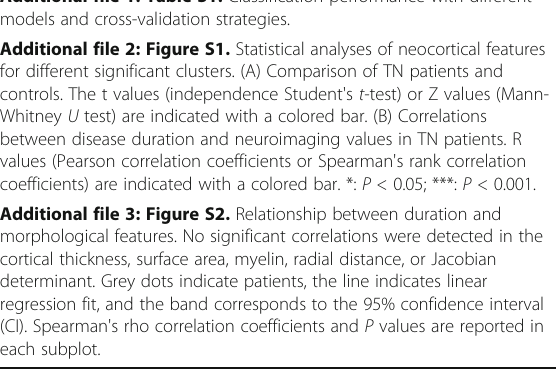
Additional file 1: Table S1. Classification performance with different models and cross-validation strategies. Additional file 2: Figure S1. Statistical analyses of neocortical features for different significant clusters. (A) Comparison of TN patients and controls. The t values (independence Student's t- test) or Z values (Mann- Whitney U test) are indicated with a colored bar. (B) Correlations between disease duration and neuroimaging values in TN patients. R values (Pearson correlation coefficients or Spearman's rank correlation coefficients) are indicated with a colored bar. *: P < 0.05; ***: P < 0.001. Additional file 3: Figure S2. Relationship between duration and morphological features. No significant correlations were detected in the cortical thickness, surface area, myelin, radial distance, or Jacobian determinant. Grey dots indicate patients, the line indicates linear regression fit, and the band corresponds to the 95% confidence interval (CI). Spearman's rho correlation coefficients and P values are reported in each